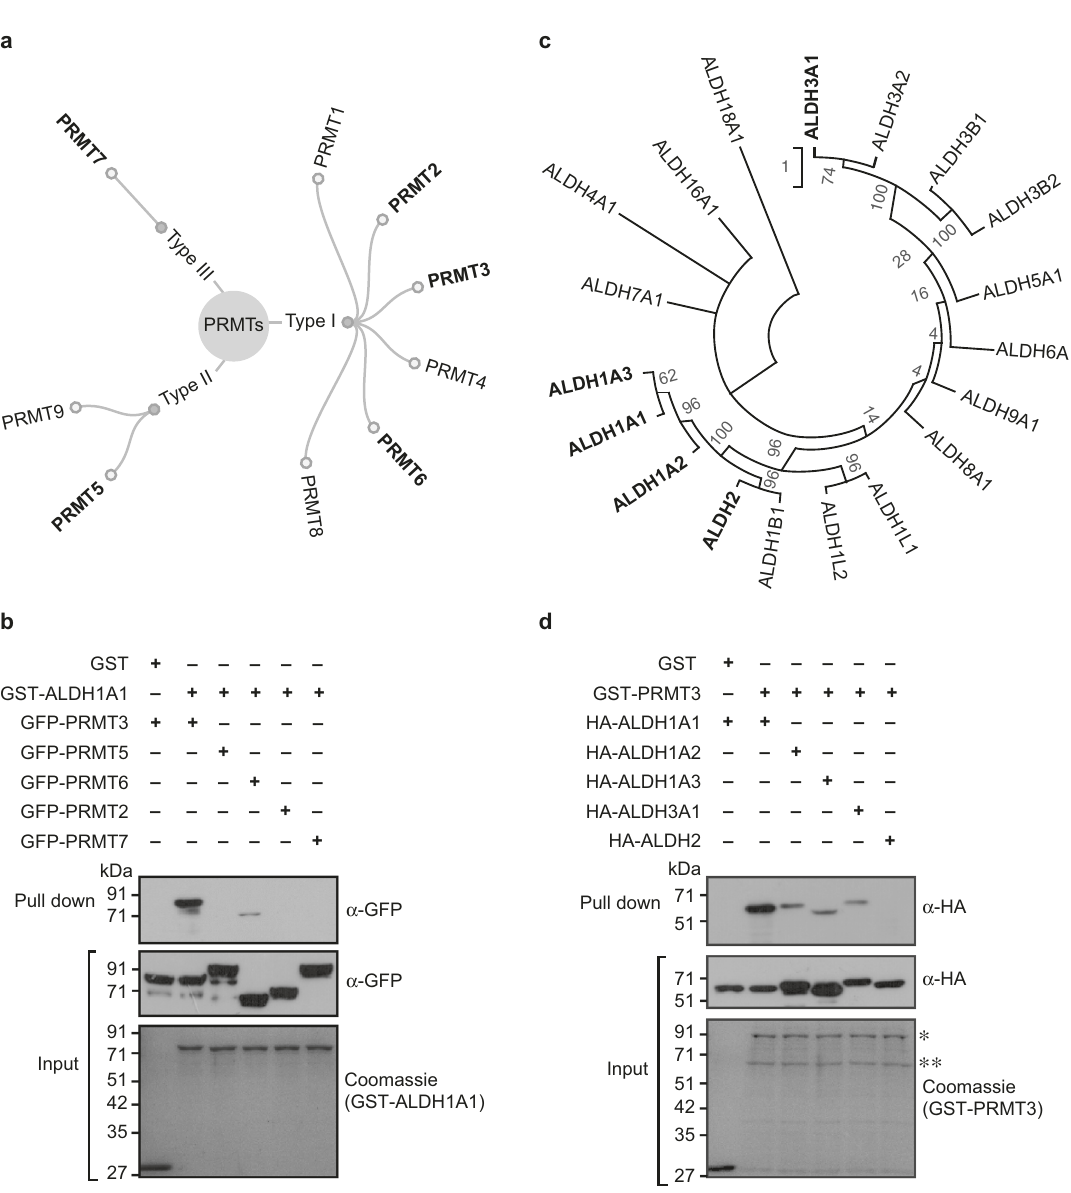
Fig. 2 PRMT3 exhibits strong binding with ALDH1A1. a Based on the type of methylarginine that they generate, different members of protein arginine methyltransferases are classi fi ed into type I (that generate asymmetric dimethylarginine), type II (that generate symmetric dimethylarginine), and type III (that generate monomethyl arginine). b ALDH1A1 interacts with PRMT3 strongly. The GST-tagged ALDH1A1 or GST protein was coupled to glutathione sepharose, and the beads were incubated with the whole-cell extracts prepared from HEK293 cells overexpressing GFP-PRMT3 or GFP-PRMT2 or GFP- PRMT5 or GFP-PRMT6 or GFP-PRMT7. The bound fractions were immunoblotted with GFP antibody (upper blot). The whole-cell extracts were probed with GFP antibody (middle blot). About 2.5% of GST and GST-tagged ALDH1A1 (lower blot), used in the pull-down assay, were separated in SDS-PAGE and stained with coomassie blue dye. c Phylogenetic tree showing the relationship among different human ALDH family of enzymes, obtained using multiple sequence alignment of the protein sequences. Multiple sequence alignment was generated using MAFFT 63 and the phylogenetic tree was reconstructed using MEGA-X 76 . d PRMT3 interacts with ALDH1A1 strongly. The GST-tagged PRMT3 or GST protein was coupled to glutathione sepharose and the beads were incubated with the whole-cell extracts prepared from HEK293 cells overexpressing HA-ALDH1A1 or HA-ALDH1A2 or HA-ALDH1A3 or HA-ALDH3A1 or HA-ALDH2. The bound fractions were immunoblotted with HA antibody (upper blot). The whole-cell extracts were probed with HA antibody (middle blot). About 2.5% of GST and GST-tagged PRMT3 (lower blot), used in the pull-down assay, were separated in SDS-PAGE and stained with coomassie blue dye. *Indicates the full-length GST-PRMT3, and **indicates the degraded GST-PRMT3 (Supplementary Fig.